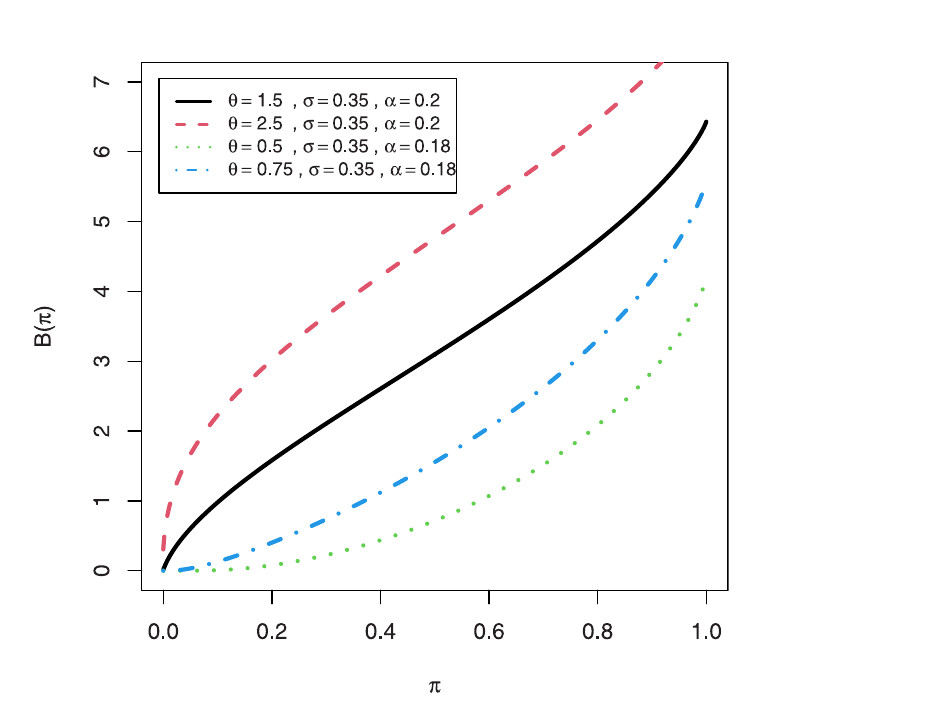
Fig 14. Plots of the Bonferroni curves of EGuNH distribution.